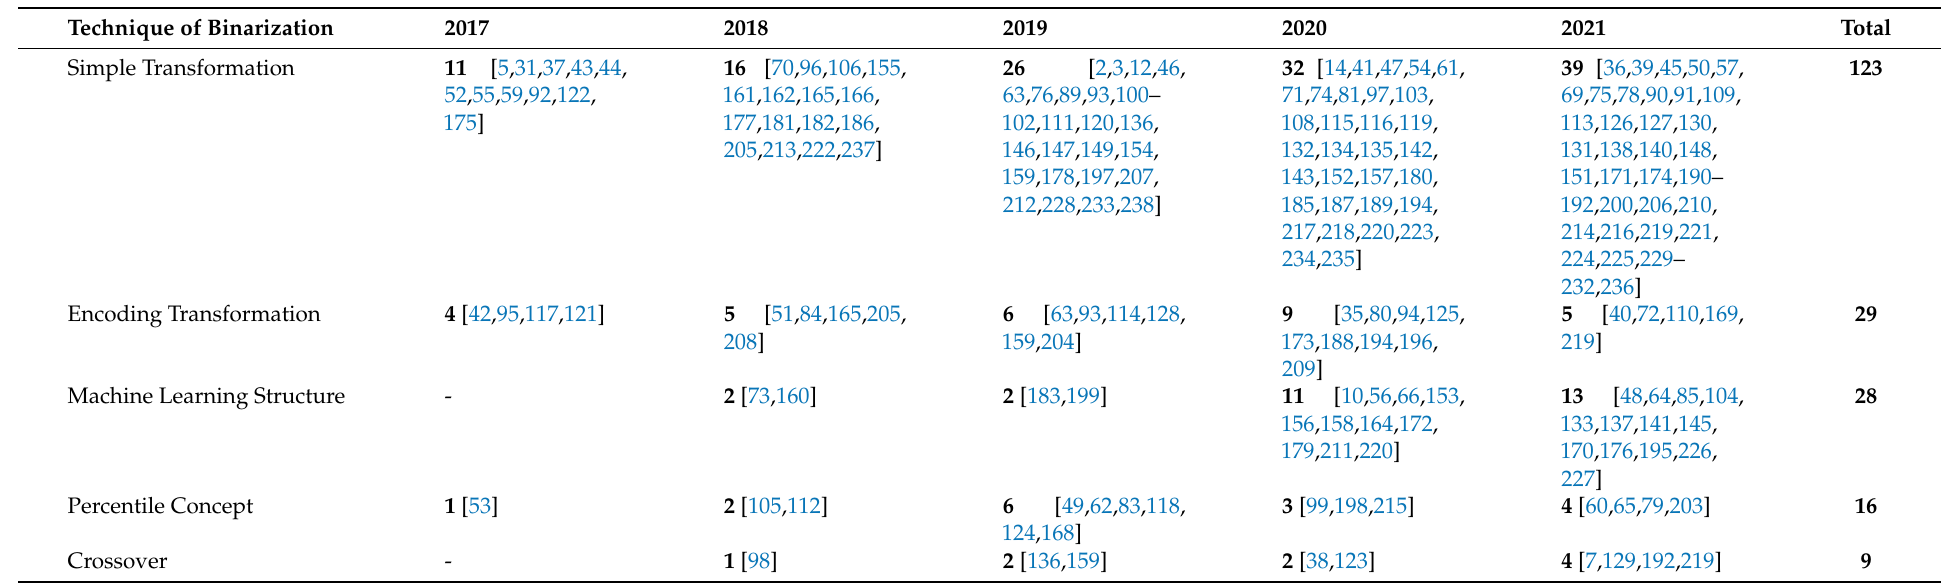
Table 7. Technique of Binarization per